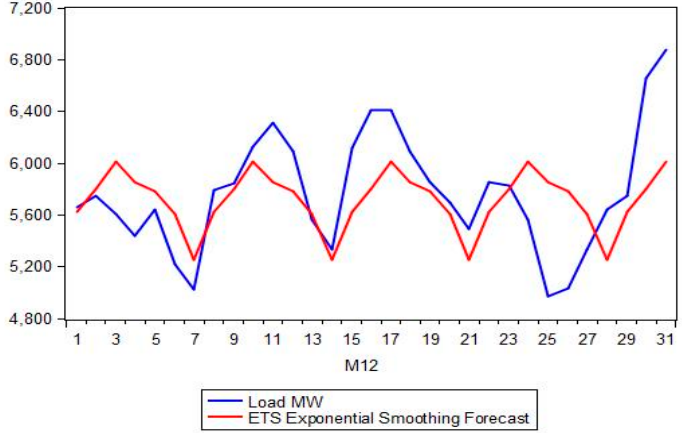
Figure 20. Exponential smoothing forecast for December 2014.